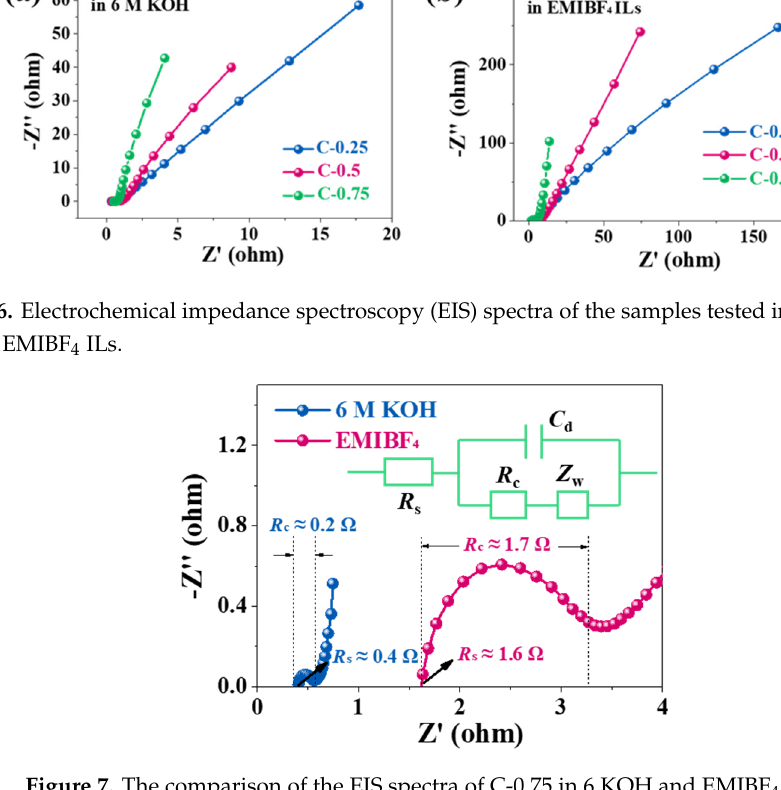
Figure 7. The comparison of the EIS spectra of C-0.75 in 6 KOH and EMIBF 4 ILs.